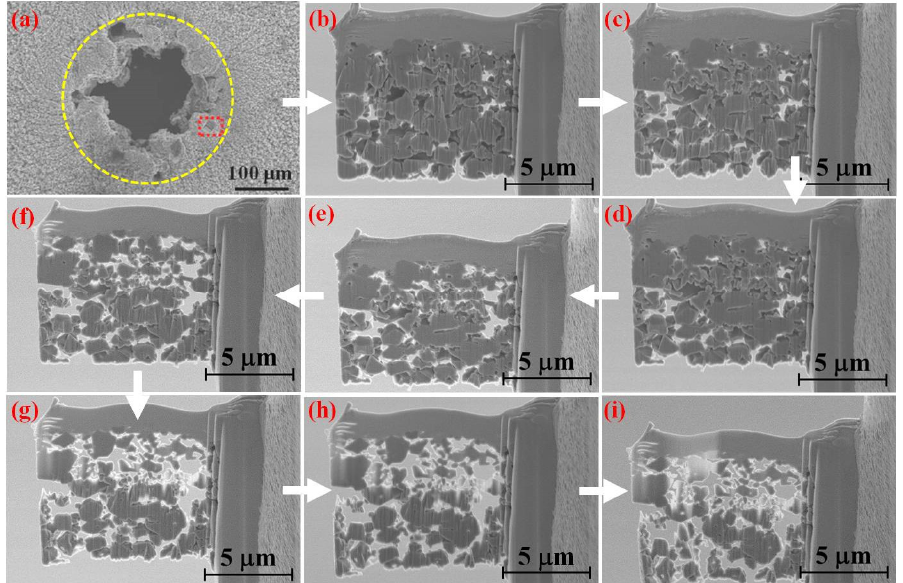
Figure 7. Cross-section morphology of different sputtering times of the micro-orifice after 500 h of immersion at 290 °C observed by FIB-SEM. ( a ) A small piece of deposit was cut and lifted out by FIB in the rectangle. ( b – i ) The interval between each photo was 6 min.